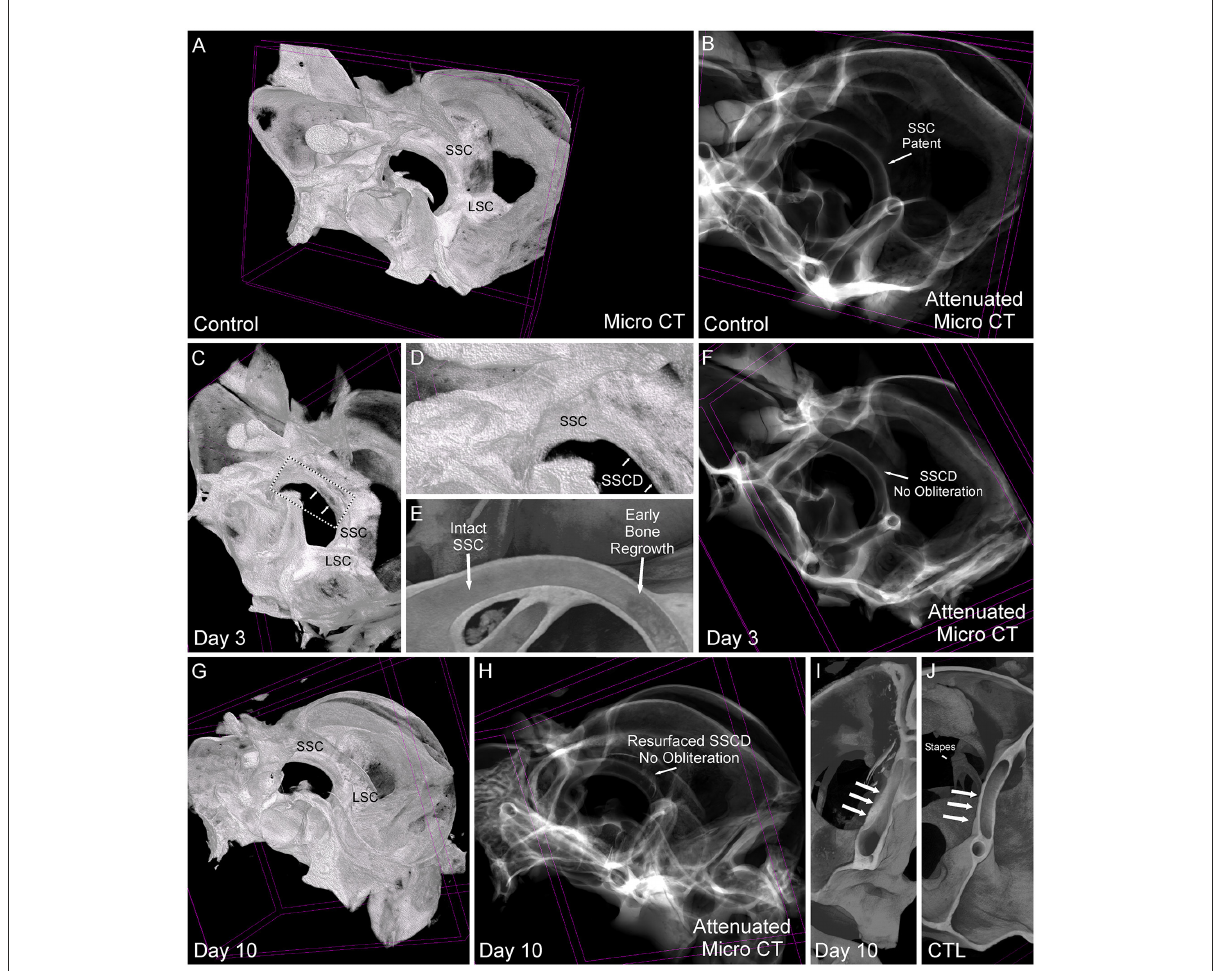
FIGURE6 Comparative micro-CT analysis of control and post-SSCD day 3 and day 10. (A) Micro-CT scan of left control (A, B, J) , day 3 post-superior semicircular canal dehiscence (SSCD) (C–F) , and day 10 post-SSCD (G–I) after small (1mm) SSCD surgery. (A) Micro-CT maximum intensity projections (MIP) with a 3D rendering of control left inner ear. Note the normal intact superior semicircular canal (SSC) and lateral semicircular canal (LSC). (B) Micro-CT with attenuated images shows that the lumen of the SSC is naturally patent. (C) Micro-CT MIP with 3D rendering shows the day 3 post-SSCD site of a small (1mm) SSCD (double arrows). Note the position of the SSC and LSC. A bounding box containing the SSCD (double arrows) is shown in higher magnification in (D) . (D) The SSC with the beginning of osteoneogenesis within the SSCD can be seen (double arrows). (E) The micro-CT view inside of the intact SSC (left) reveals the adjacent early bone regrowth (right) at day 3 post-SSCD. (F) Micro-CT with attenuated images shows that the lumen remains patent at day 3 post-SSCD. (G) Micro-CT MIP with 3D rendering of a small (1mm) SSCD on postoperative day 10. Note the positions of the SSC and LSC. (H) Micro-CT with attenuated images shows that the lumen remains patent and without bony obliteration, as is the normal condition shown in (B) . (I) Micro-CT view inside the left SSC on day 10 post-SSCD [small (1mm) fenestration]. Note the increased thickness of the resurfaced SSC bone (triple arrows) compared to the control SSC has shown in (J) . (I) Micro-CT inside the left SSC shows that the natural SSC has uniform wall thickness (triple arrows) that is thinner than the resurfaced/regrown SSC. CTL,